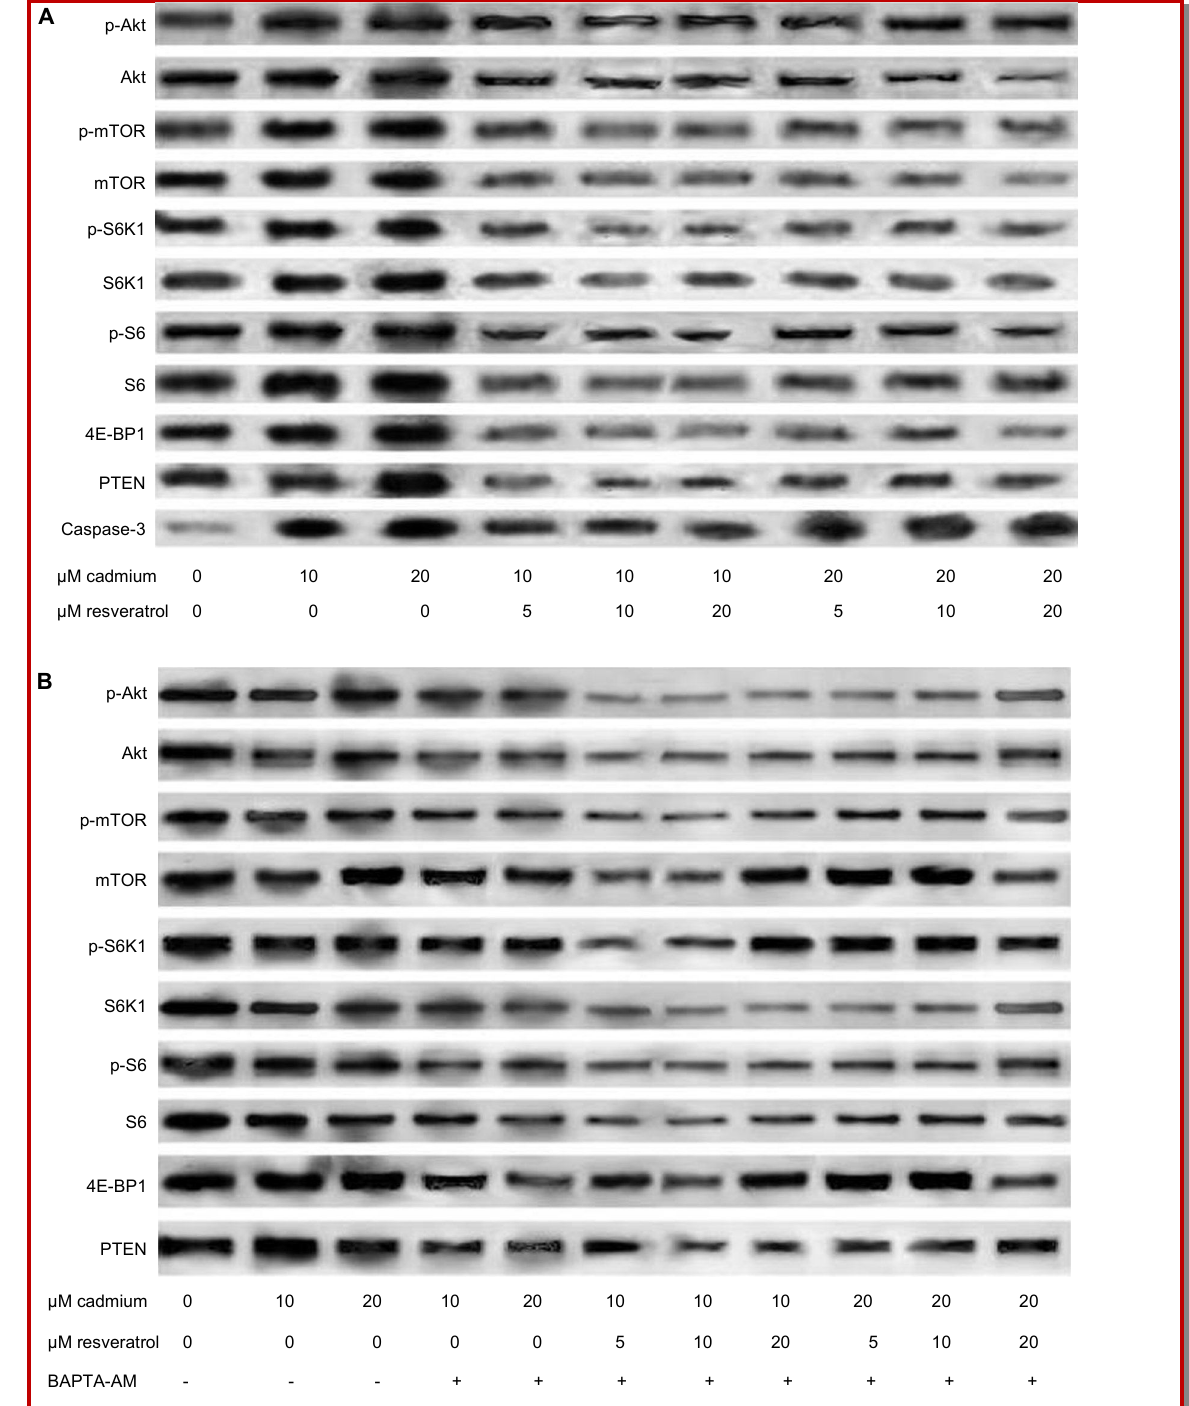
Figure 4: Resveratrol prevents cadmium induced neuronal cell death by modulating PTEN expression and Akt/ mTOR